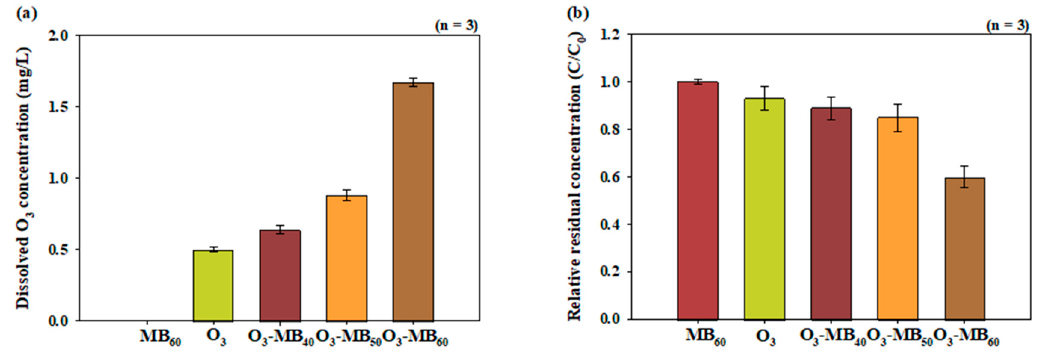
Figure 4. The changes in the concentrations of dissolved O 3 and the degradation of p CBA in the aqueous phase as a function of the cavity pump frequency (the initial concentration of p CBA = 2.0 µ M; pH = 7.0; temperature = 20 ◦ C; reaction time = 300 seconds; MB 60 = microbubble at 60 Hz without O 3 ; O 3 = millibubble ozonation at 30 Hz; O 3 -MB 40 = microbubble ozonation at 40 Hz; O 3 -MB 50 = microbubble ozonation at 50 Hz; O 3 -MB 60 = microbubble ozonation at 60 Hz): ( a ) the concentration of dissolved O 3 and ( b ) the relative residual concentration (C / C 0 ) of p CBA.